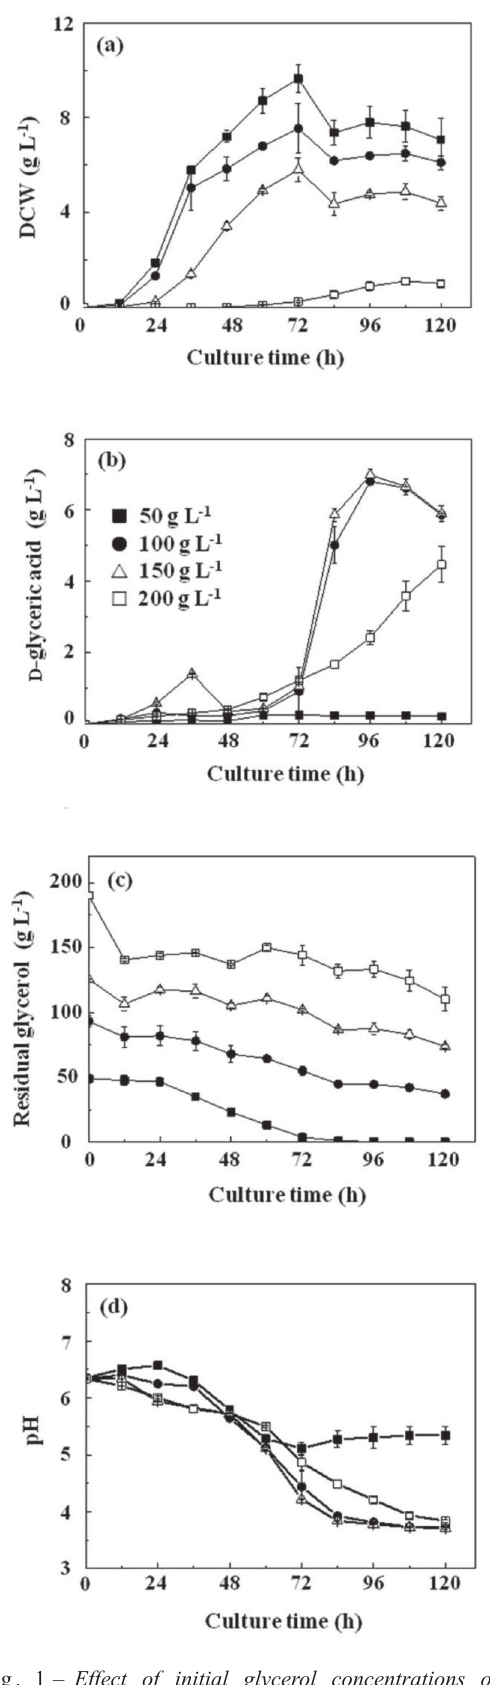
Fig. 1 – Effect of initial glycerol concentrations on cell growth and D-GA yield (a) DCW; (b) D-GA; (c) residual glyc- erol; (d)